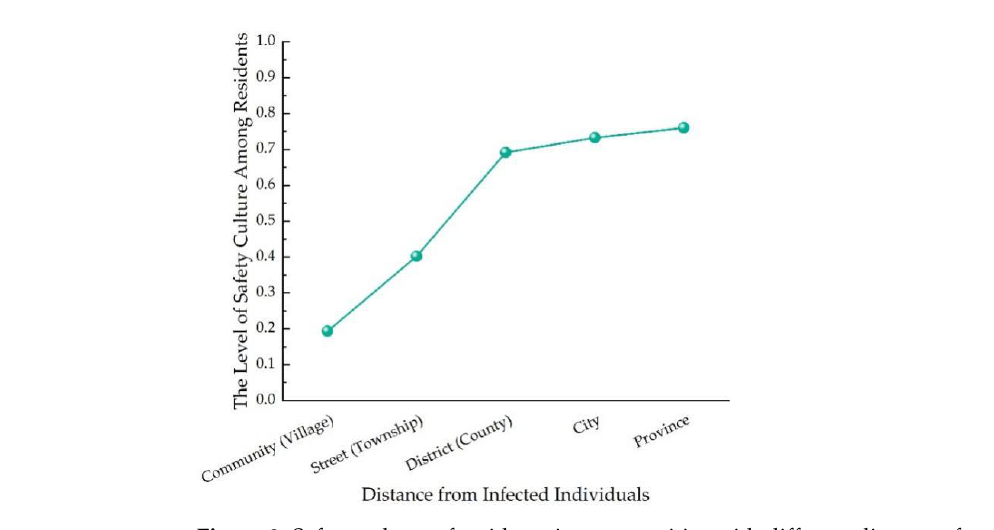
Figure 9. Safety culture of residents in communities with different distances from COVID-19 cases.